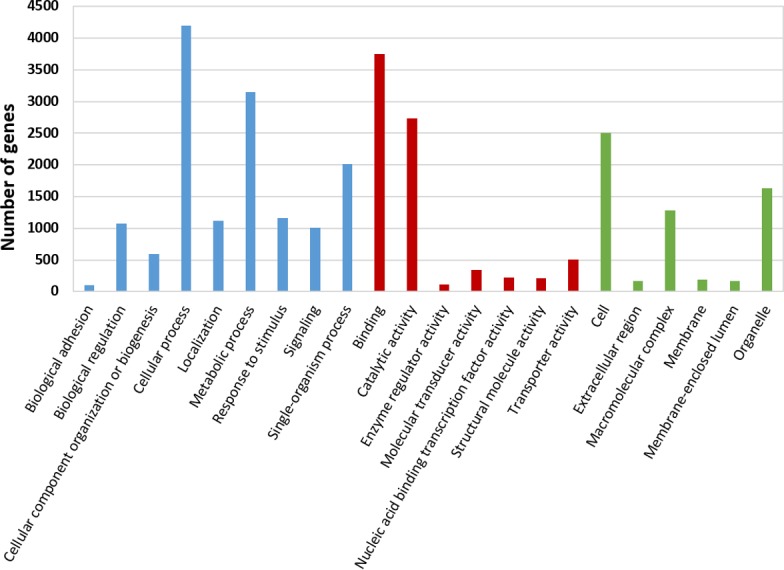
Gene Ontology (GO) annotations for the reference transcriptome of Aphidius ervi separated by GO categories (Biological process: blue. Molecular function: red. Cellular component: green).